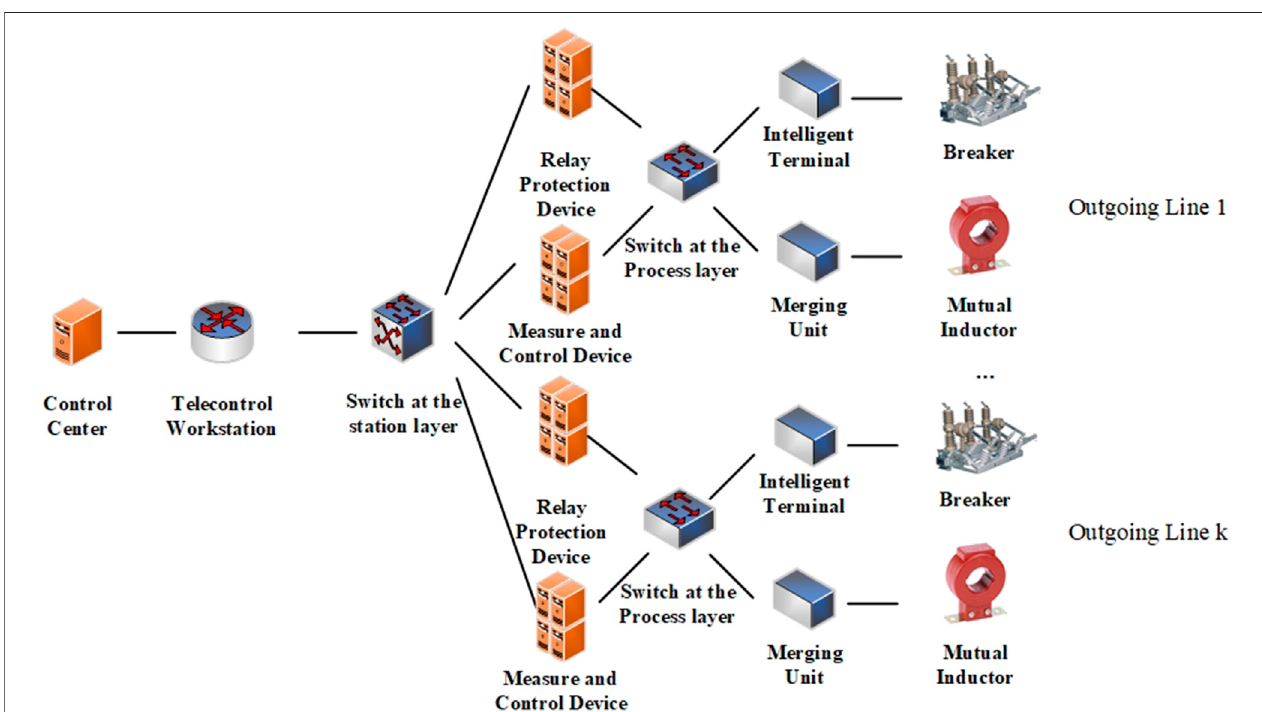
FIGURE 3 | Model of substation communication